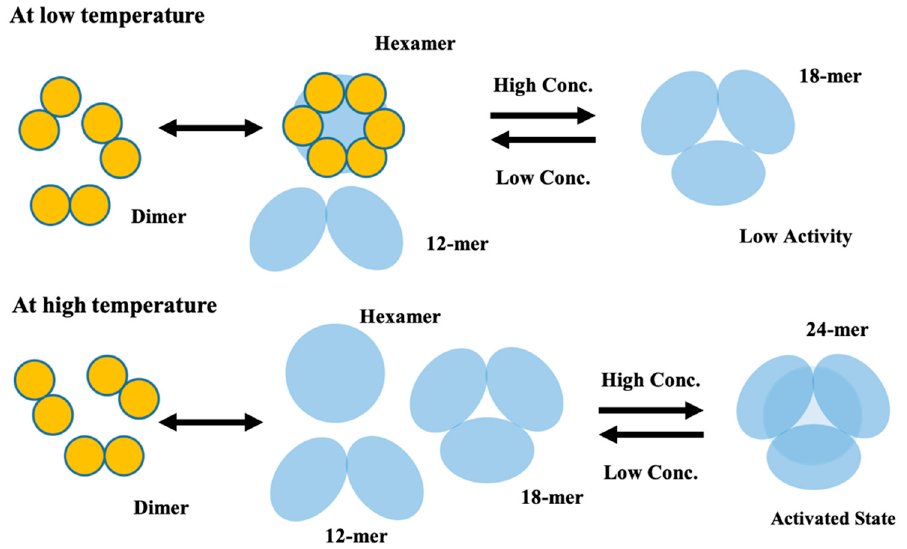
Figure 7. Schematic conformation transition model of CgHspB1.